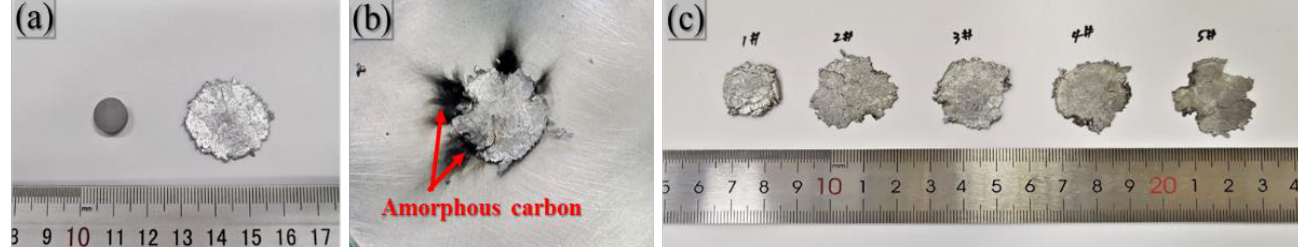
Figure 7. Specimen before and after drop-weight test: ( a ) unreacted specimen before and after drop weight test; ( b ) reacted specimen; ( c ) reacted specimen of different Bi 2 O 3 contents.